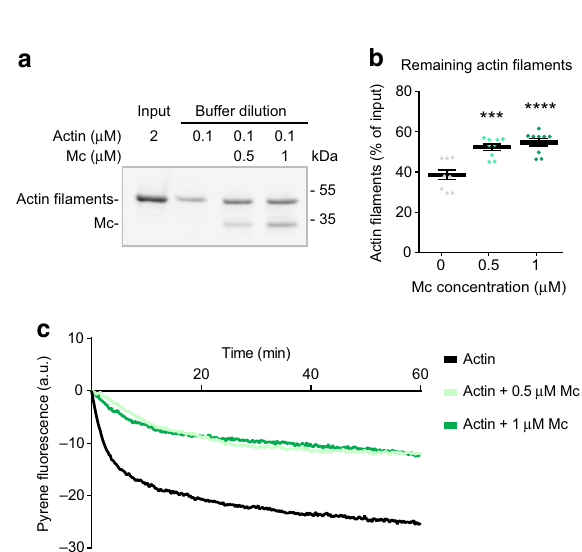
Fig. 6 Mc modules protect actin fi laments from depolymerisation. a Actin depolymerisation induced by dilution of actin fi laments alone or in the presence of Mc modules. After 20 min of incubation in a buffer containing 0.1 µ M actin (alone or with 0.5 µ m or 1 µ M Mc), samples were centrifuged at 100,000× g and pellets separated on SDS/PAGE and detected by Stain- Free system. b Quanti fi cation of the percentage of remaining actin fi laments after buffer dilution. Data presented as mean ± SEM. (*** p < 0.001, **** p < 0.0001, one-way ANOVA and Sidak ’ s post hoc test), n = 9 gels from three independent experiments. c Mean time course of actin fi laments and Mc-decorated actin fi laments depolymerisation. After 1 h incubation of 40% pyrene-labelled actin fi laments alone or in the presence of Mc modules, all samples were diluted to a fi nal concentration of 0.1 µ